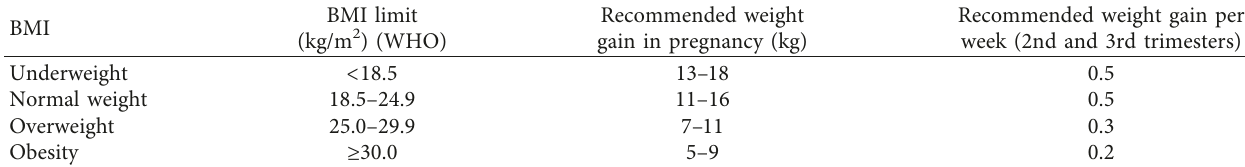
Table 3: Weight gain in pregnancy according to preconceptional BMI, adapted by IOM Guidelines 2009